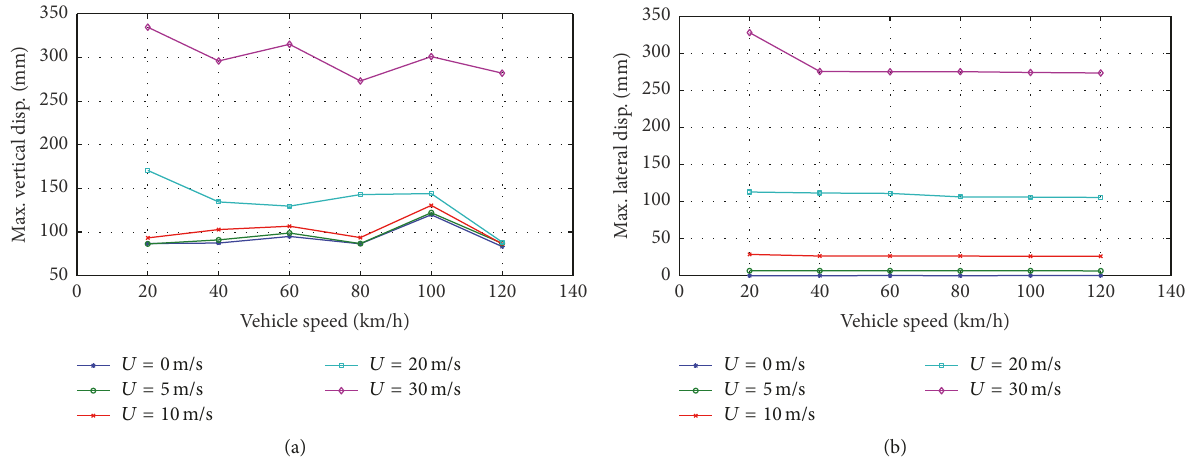
Figure 19: Maximum responses of the Skytrain Bridge at center under various wind and vehicle speeds: (a) vertical displacement, (b) lateral displacement.